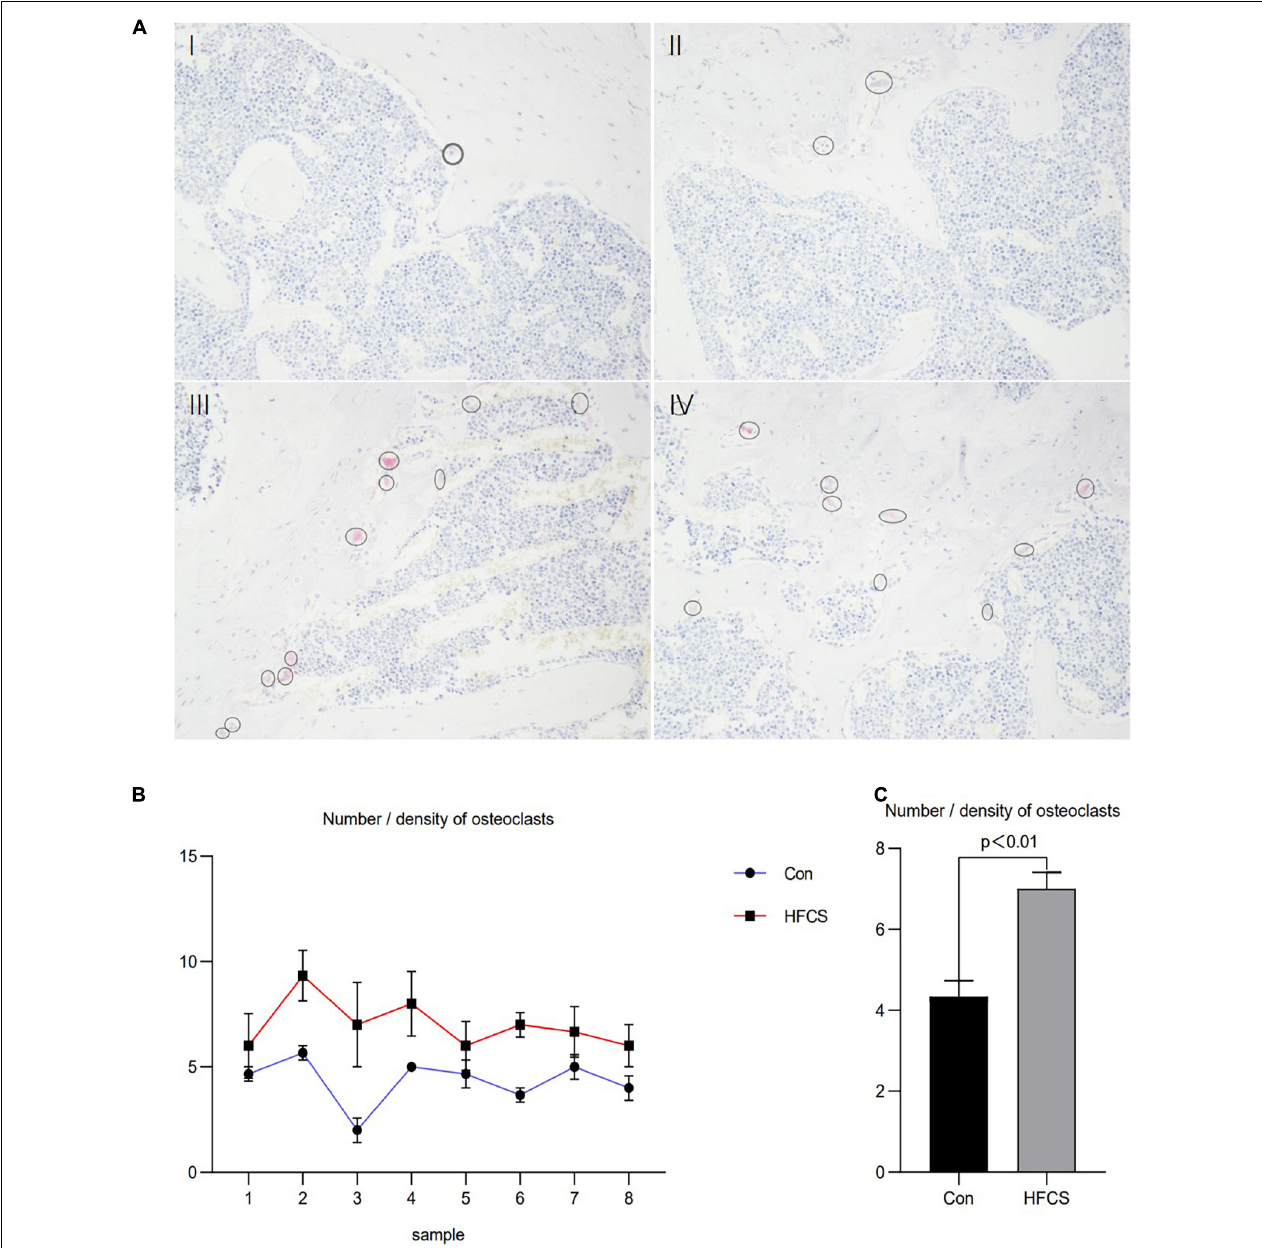
FIGURE 2 | Effect of HFCS on the number and density of osteoclasts in male mice. Results of TRAP staining of mouse femurs showing in (A) , control (I, II) and HFCS (III, IV) groups. Image magnification 200 times, the circles and ellipses showing are osteoclasts. Plot of the number/density of osteoclasts in the femurs of the eight mice (B) . The average number/density of osteoclasts in the femurs of mice (C) . Data was expressed as mean ± SEM ( n = 8) and analyzed by one-way ANOVA